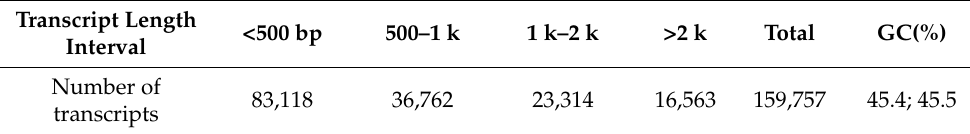
Table 3. Frequency distribution of assembly length.